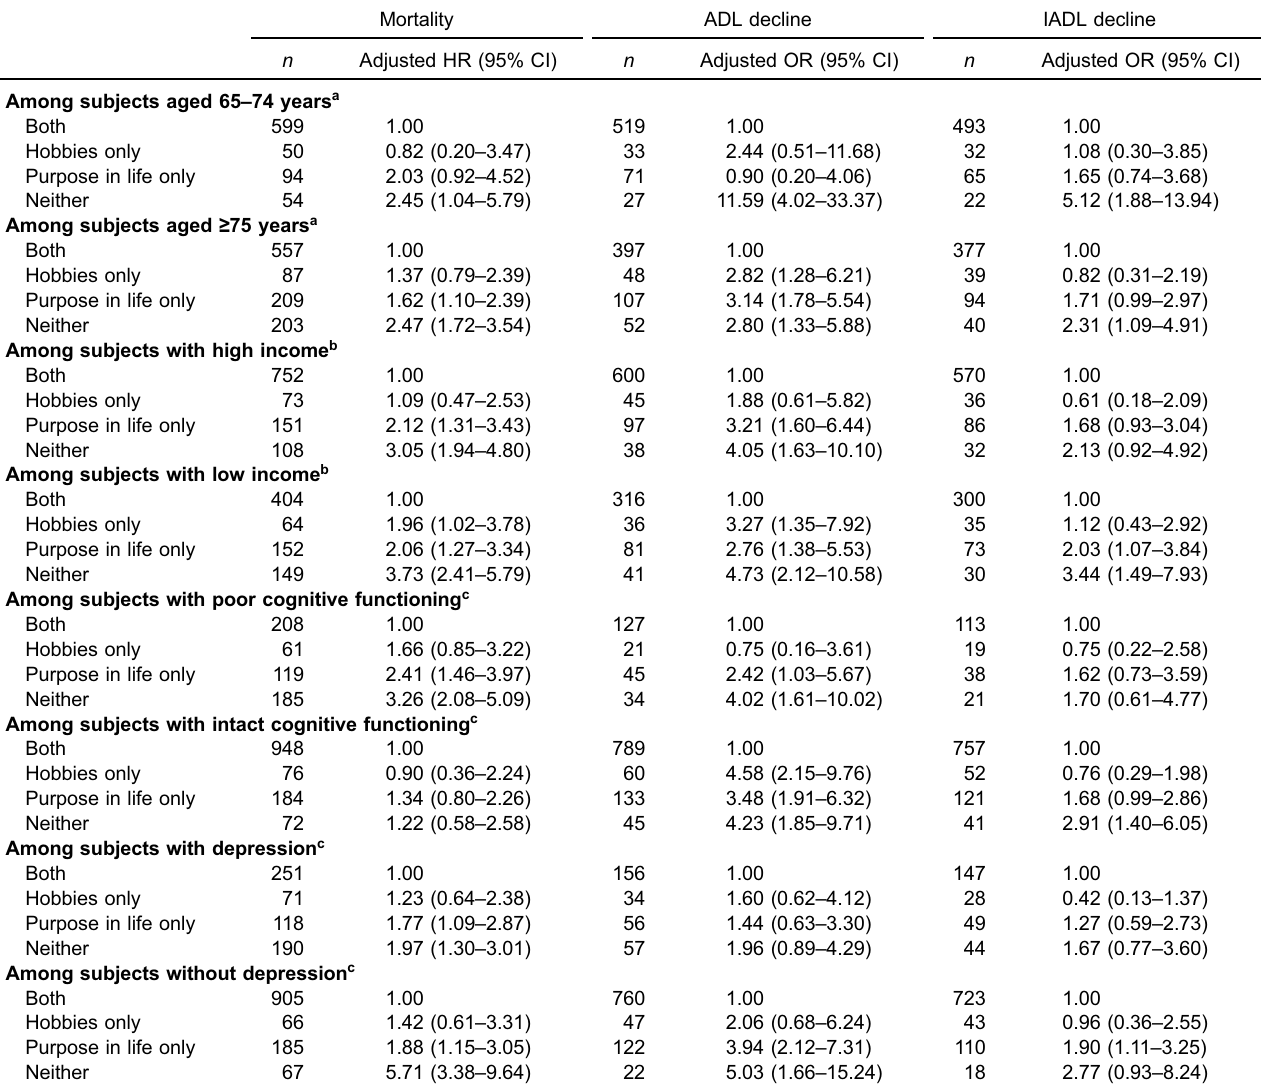
Table 4. Strati fi ed analyses by age, income, cognitive functioning, and depression Mortality ADL